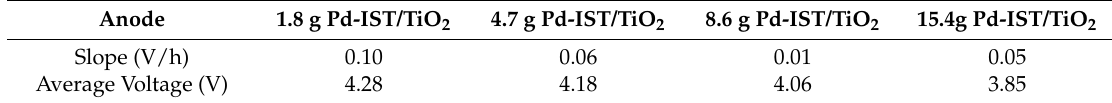
Figure 4. Accelerated life test of Pd-based electrodes viz: ( a ) 1.8 g Pd-IST/TiO 2 ; ( b ) 4.7 g Pd-IST/TiO 2 ; ( c ) 8.6 g Pd-IST/TiO 2 ; ( d ) 15.4 g Pd-IST/TiO 2 . Table 4. The results of accelerated life test.